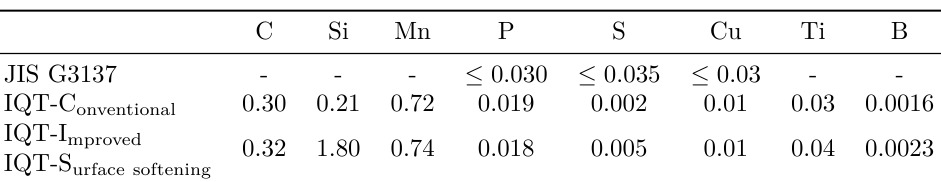
Table 1. Chemical composition of test materials(mass%).